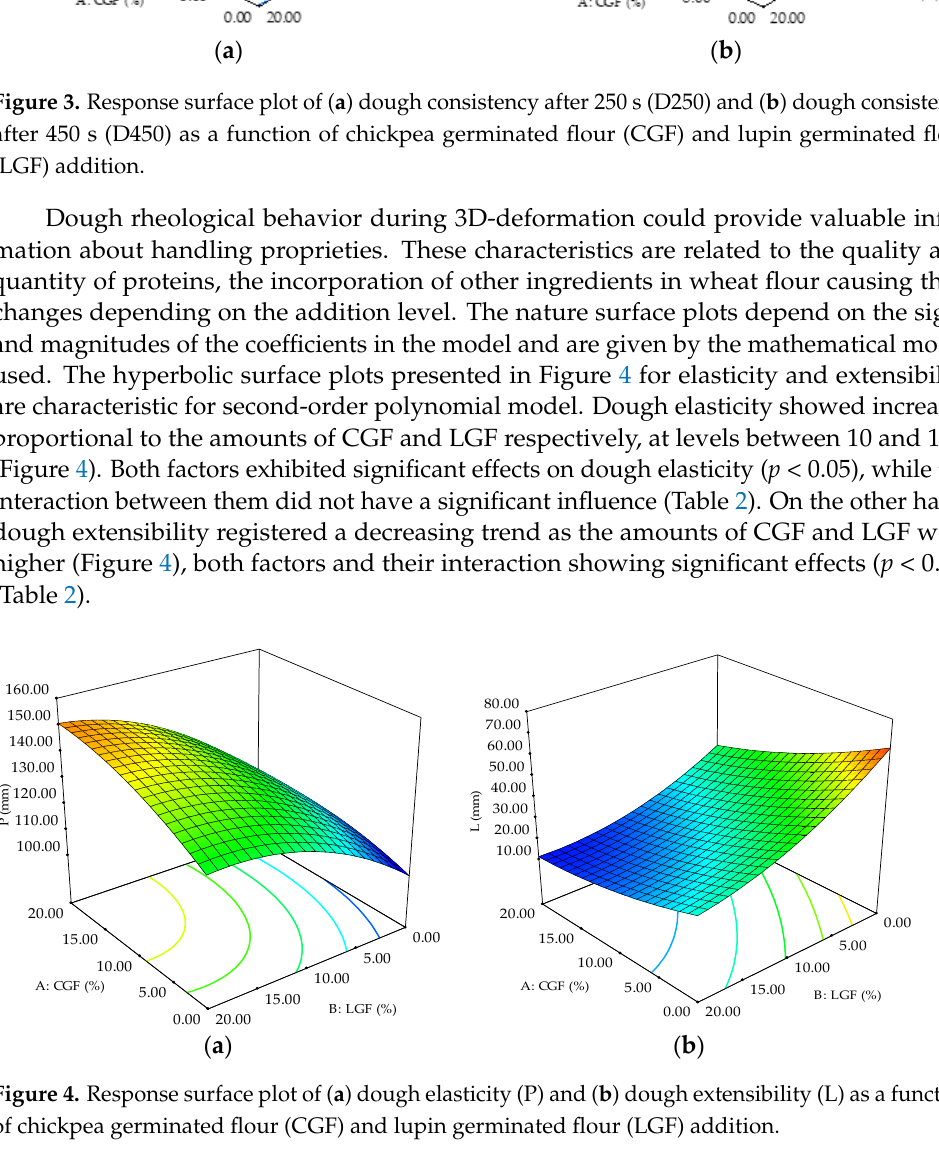
( b ) Figure 5. Response surface plot of ( a ) dough alveograph energy (W) and ( b ) alveograph curve ra- tio(P/L) as a function of chickpea germinated flour (CGF) and lupin germinated flour (LGF) addi- tion. 3.4. Influence of CGF and LGF on Dough Rheological Behavior during Fermentation Dough rheological properties during fermentation were changed by CGF and LGF incorporated in wheat flour. For the volume of the gas retained in the dough at the end of the test data variation the 2FI model was selected, a good fitting ( R 2 = 0.84, p < 0.05) being obtained (Table 3). The results for maximum height of the gas release curve were suc- cessfully fitted to the quadratic model ( p < 0.05) which explained 84% of data variation. Dough retention coefficient data variations were explained in a proportion of 60% by the cubic model which was significant ( p < 0.05), while the data of total volume of CO 2 pro- duction were fitted to a modified cubic model ( R 2 = 0.87, p < 0.05).